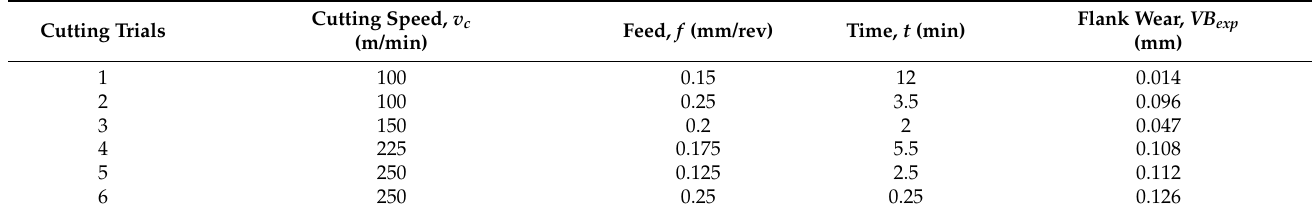
Table 3. Cutting experiments for coefficient